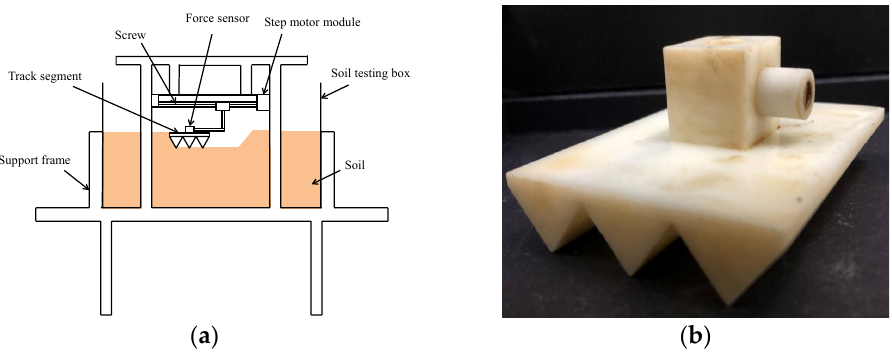
Figure 6. Shear stress–shear displacement test equipment. ( a ) Schematic diagram of soil test equip-